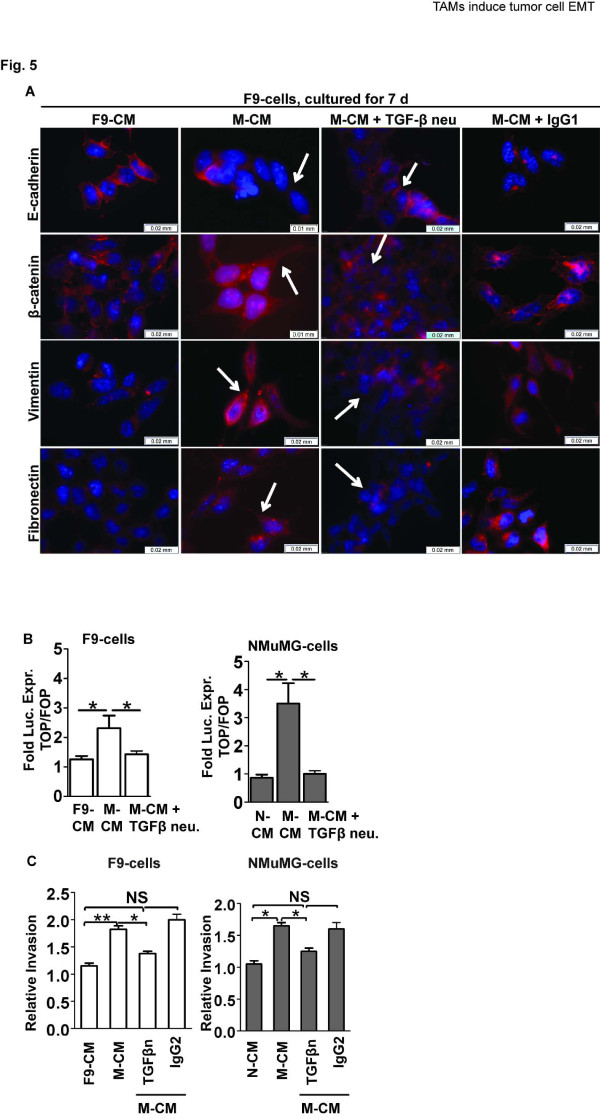
M2 macrophages regulate EMT through paracrine TGF-β signaling. (A) Immunofluorescence of E-cadherin, β-catenin, vimentin and fibronectin expression and cellular localization in F9-cells cultured in F9-CM, M-CM, M-CM neutralized for TGF-β and in M-CM plus an IgG1 control antibody for 7d. Pictures of NMuMG-cells are shown in Additional file 2: Figure S5. Scale bar = 0.02 mm. Proteins are colored red and nuclei were stained with DAPI (blue). Arrows indicate the location of the annotated protein in cells cultured in M-CM and M-CM + TGF-β neutralizing antibody for 7d. (B) Relative luciferase expression (TOPFLASH/FOPFLASH) in F9-cells (left) and NMuMG-cells (right) after 7d or 13d of culture in F9-CM, N-CM, M-CM or M-CM neutralized for TGF-β, respectively; n = 4-7; bar = means ± SEM. *P < 0.05, unpaired t-test. (C) Relative invasion by F9-cells (left) and NMuMG-cells (right) in response to F9-CM, N-CM, M-CM, M-CM neutralized for TGF-β (TGF-βn), or to M-CM plus an IgG1 control antibody (48h, 1% Matrigel); n = 3-8. Fold invasion was calculated relative to F9-CM or N-CM. *P < 0.05, **P < 0.005, unpaired t-test, bar = means ± SEM.